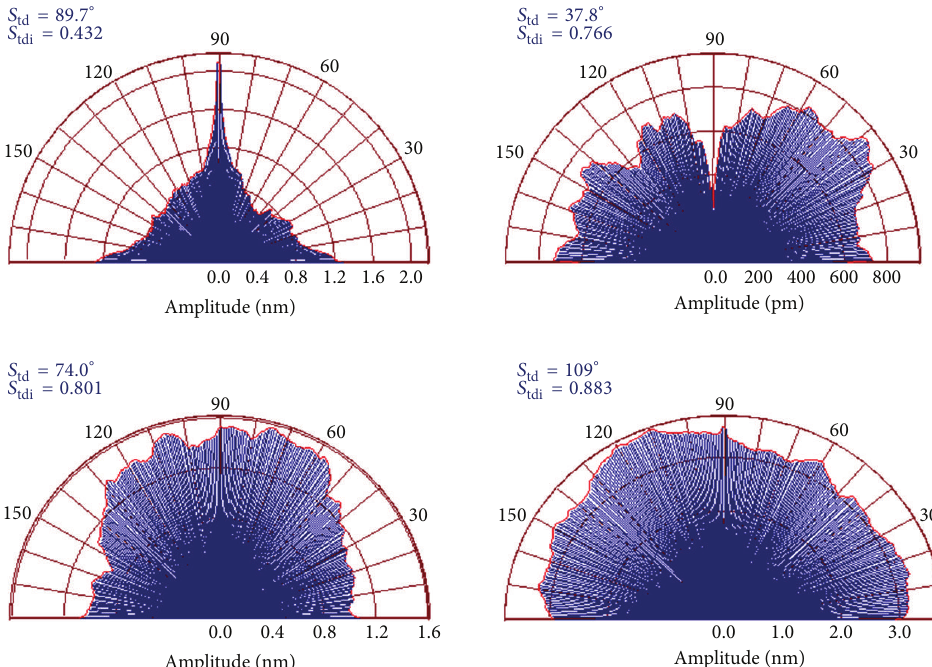
Figure 3: Angular spectra of PEDOT:PSS:Ag NPs with 60, 90, 120, and 150 𝜇 L of silver NPs from left to right, respectively.